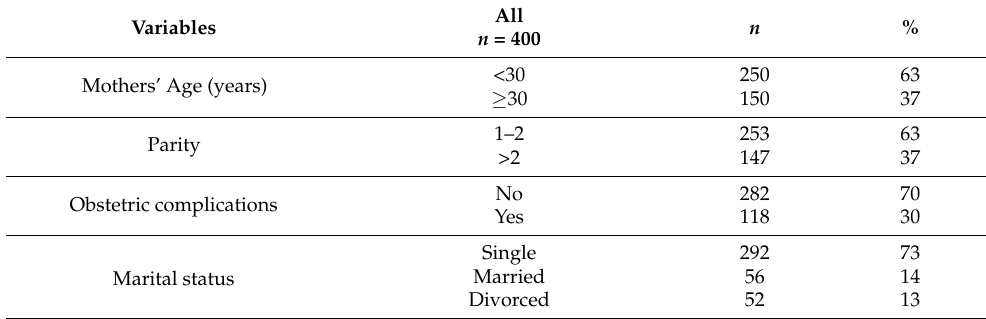
Table 2. Characteristics of